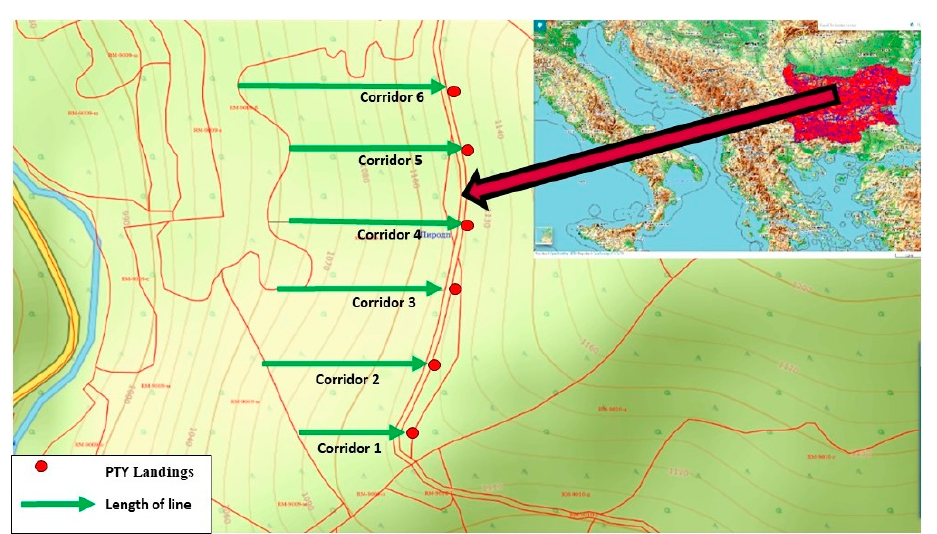
Figure 1. Site and yarding